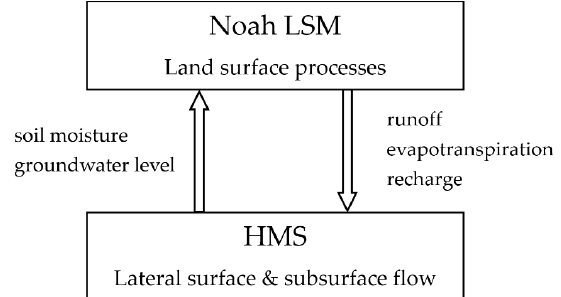
Figure 1. A schematic diagram of the coupled land surface-hydrological model system.